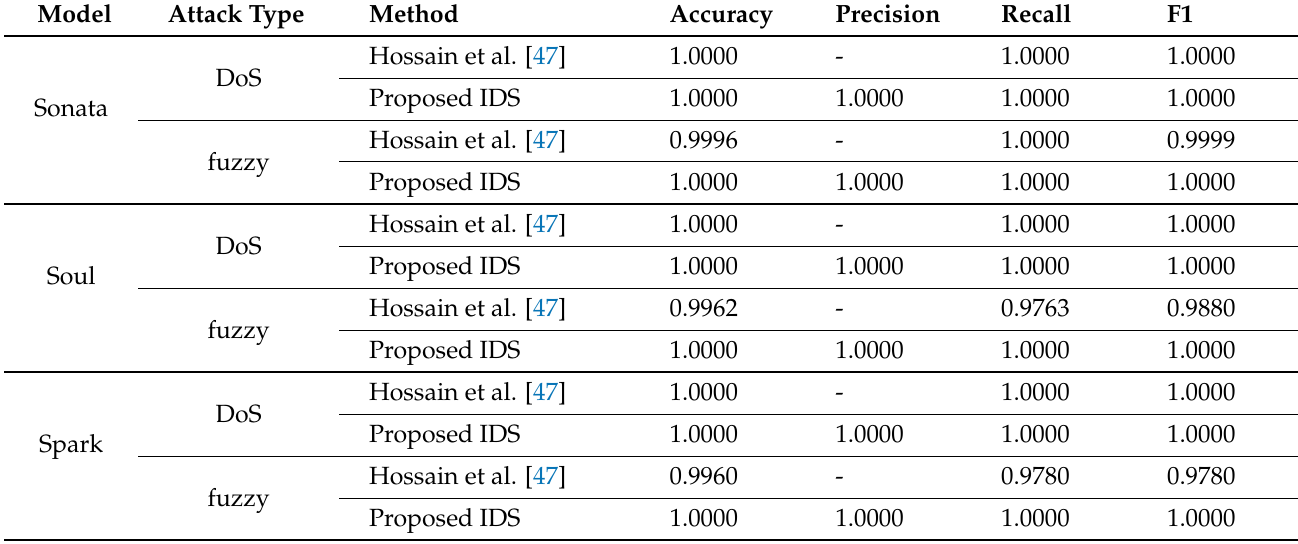
Table 17. Performance analysis against known IDS (survival analysis